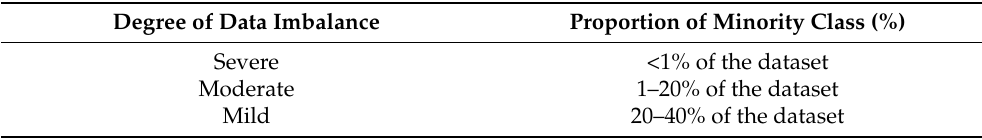
Table 1. The classification of the degree of imbalance for imbalanced